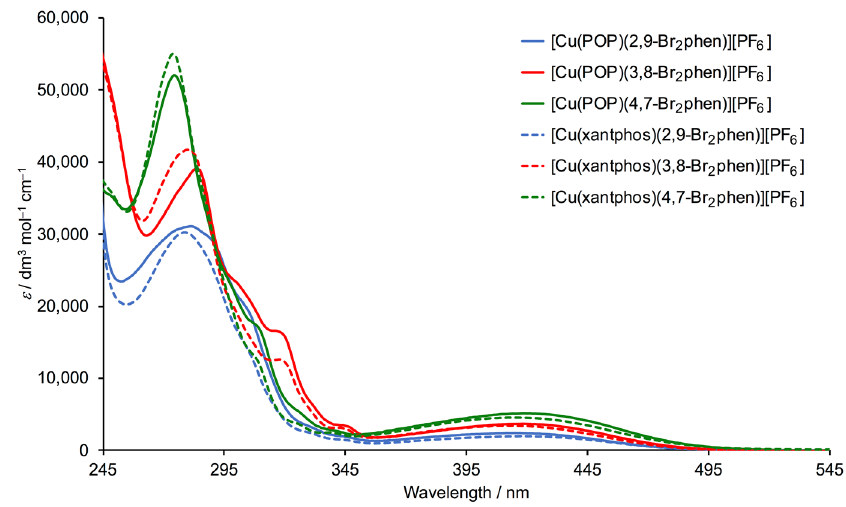
Figure 7. Solution absorption spectra of the [Cu(PˆP)(NˆN)][PF 6 ] compounds in CH 2 Cl 2 (concentrations in the range 1.75 × 10 − 5 to 3.0 × 10 − 5 mol dm − 3 ). Table 3. Solution absorption maxima for the [Cu(P^P)(N^N)][PF 6 ] compounds in CH 2 Cl 2